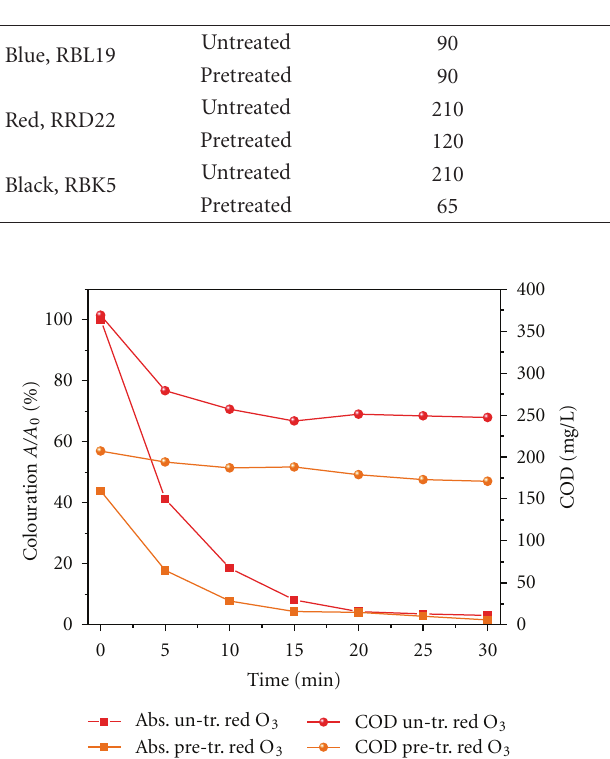
Figure 11: Colouration expressed as A/A 0 and COD values of Reactive Red 22 wastewater samples at di ff erent times of PCOz